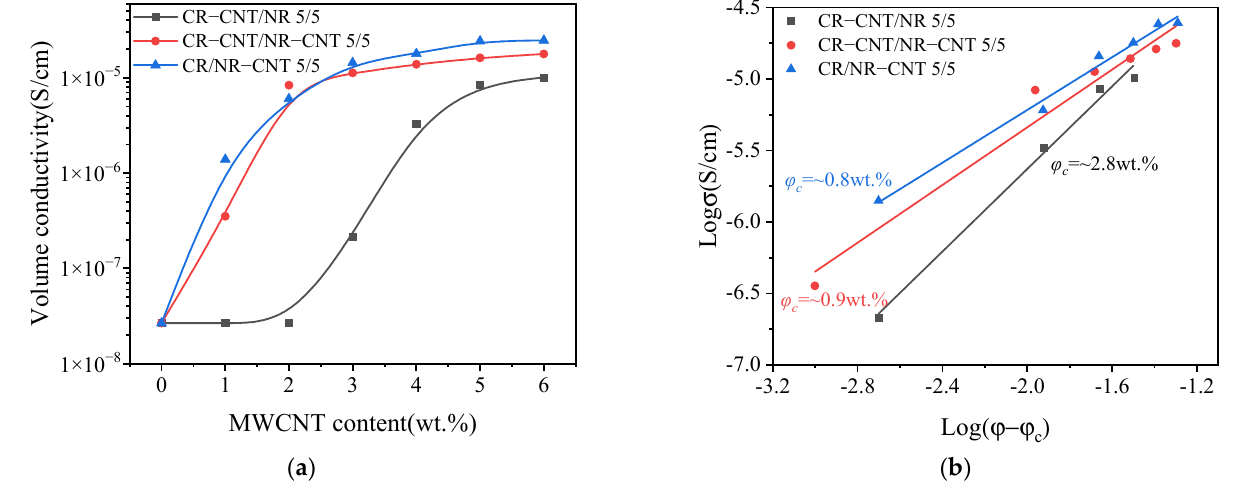
Figure 5. ( a ) The relationship between volume conductivity and MWCNT content of composites with different blending processes; ( b ) fitting curve of percolation threshold.